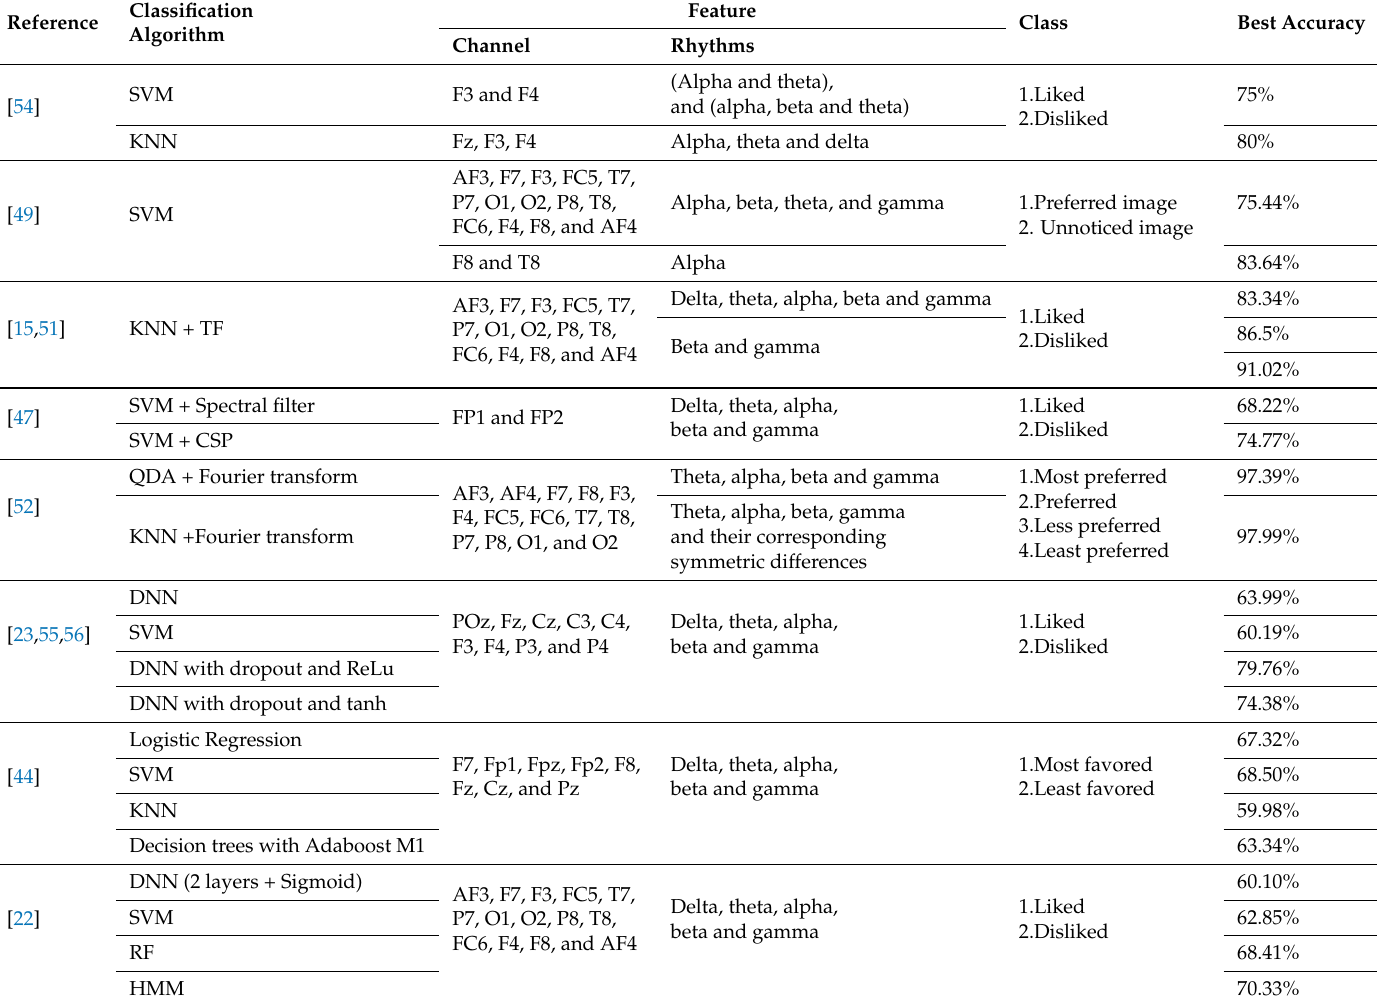
Table 6. Classification algorithms applied for recognizing the consumer